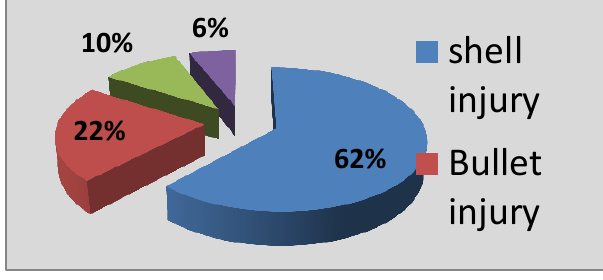
Figure 1 : The mechanism of